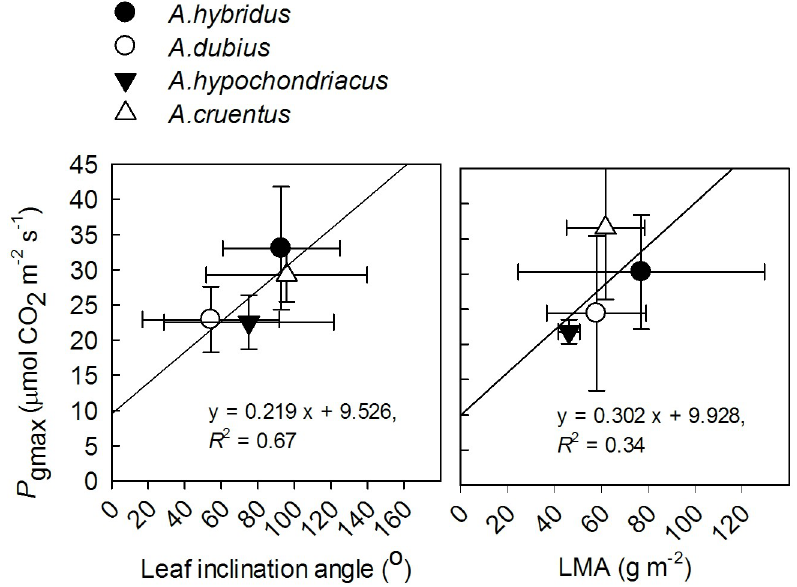
Fig 4. Relation between maximum gross photosynthesis rate ( P gmax ) and leaf inclination angle (left) and leaf dry mass per unit area (LMA) (right) at measurement date 1 (50 DAS) and 3 (63 DAS), respectively. The four data points represent the means of each species. Bars represent the ± SD of the means. DAS denotes days after